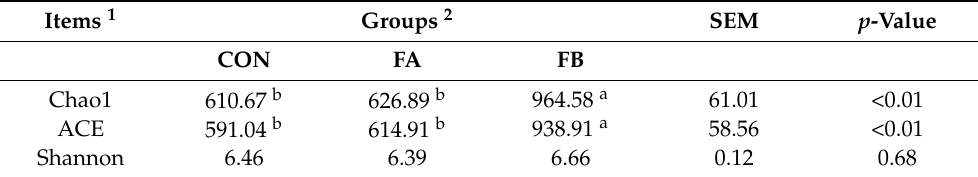
Table 7. Effect of fermented mixture on the cecal microbiota α -diversity of the laying